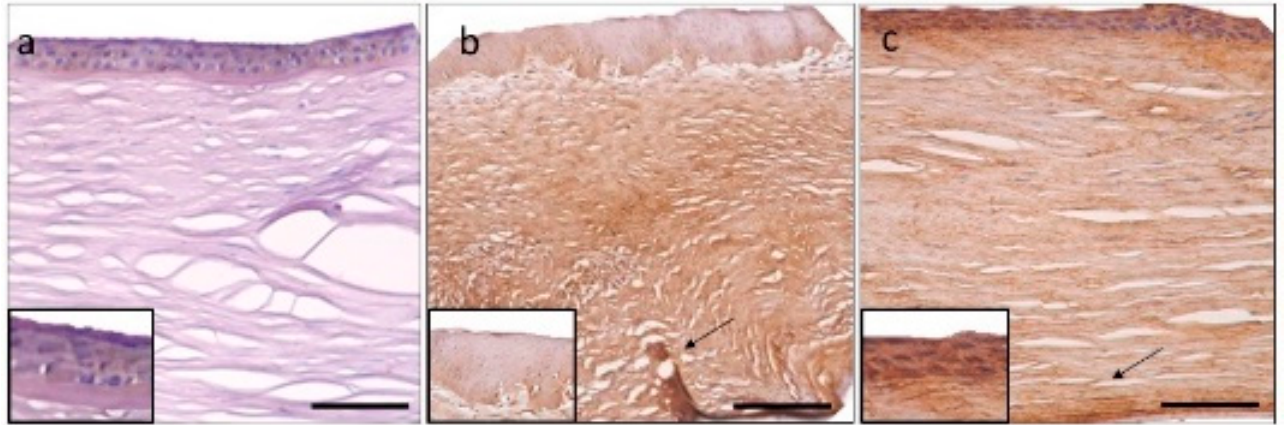
Figure 6. Aggrecan immunohistochemistry. Control section with minimal immunopositivity in the epithelium ( a ). Mild-to-moderate epithelial and stromal immunopositivity in PBK ( b ) and FECD ( c ) is present. Posterior stroma disclosed more intense labelling (arrow). Epithelial signal intensity (insets). Scale bar indicates 100 µm.